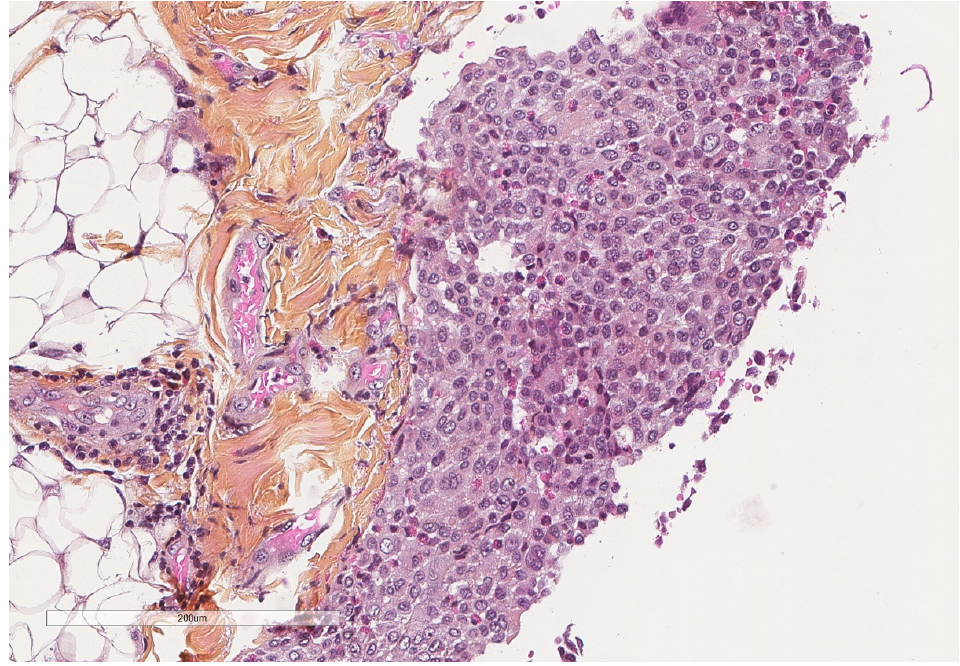
Figure 12. In pneumothorax-associated pleural effusion, macrophages intermixed with eosinophils predominate. Hematoxylin, eosin, saffron staining (×400).